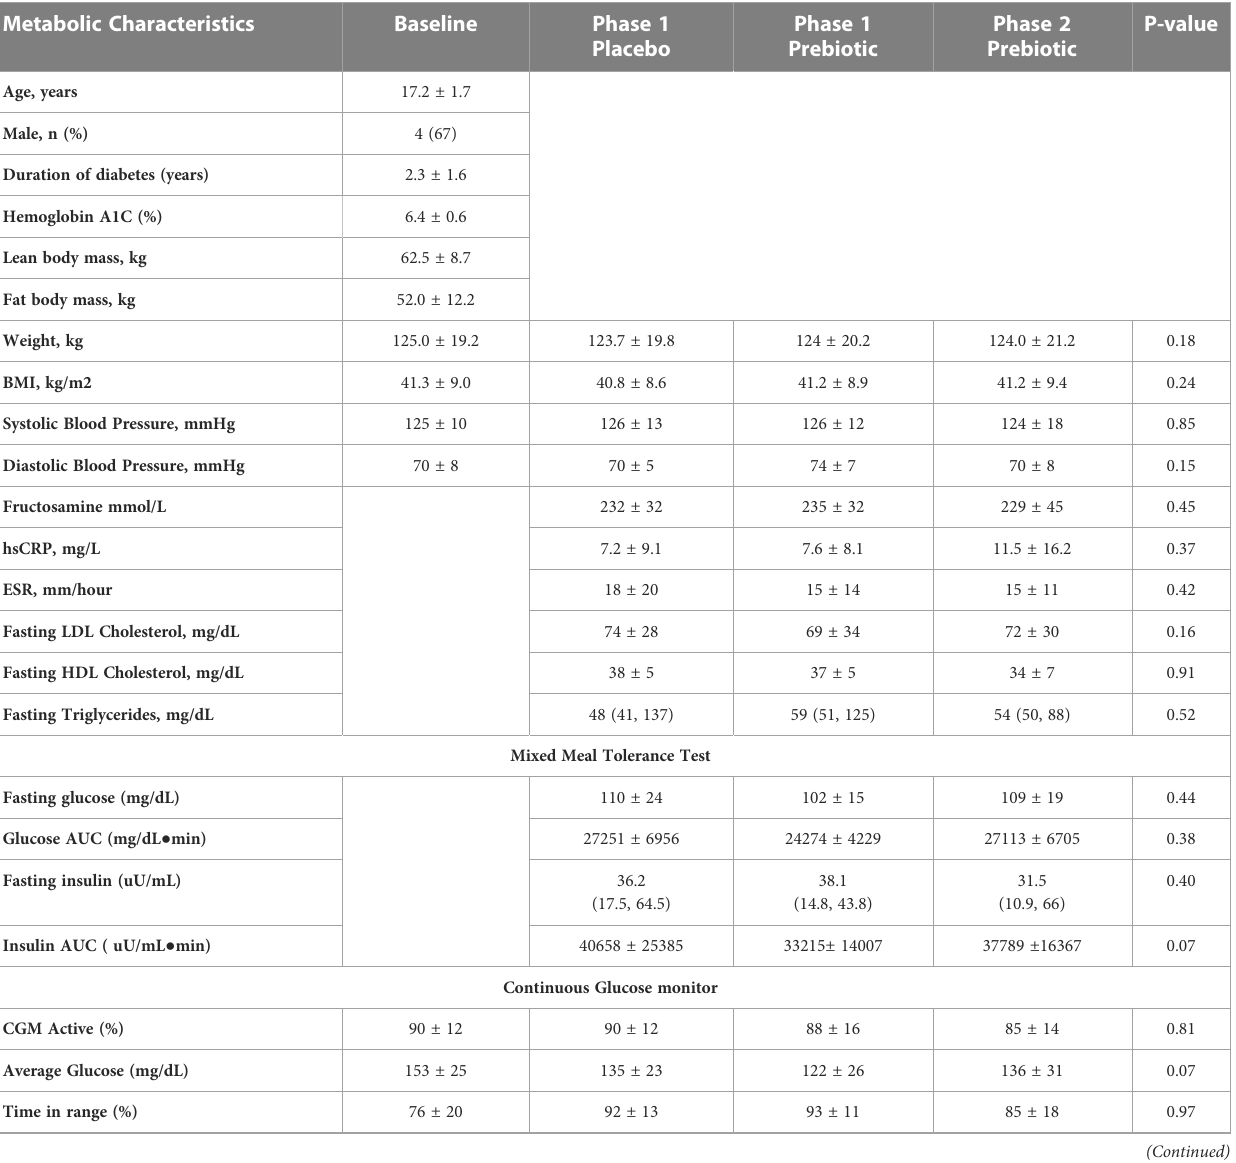
TABLE 1 Demographic and metabolic characteristics of